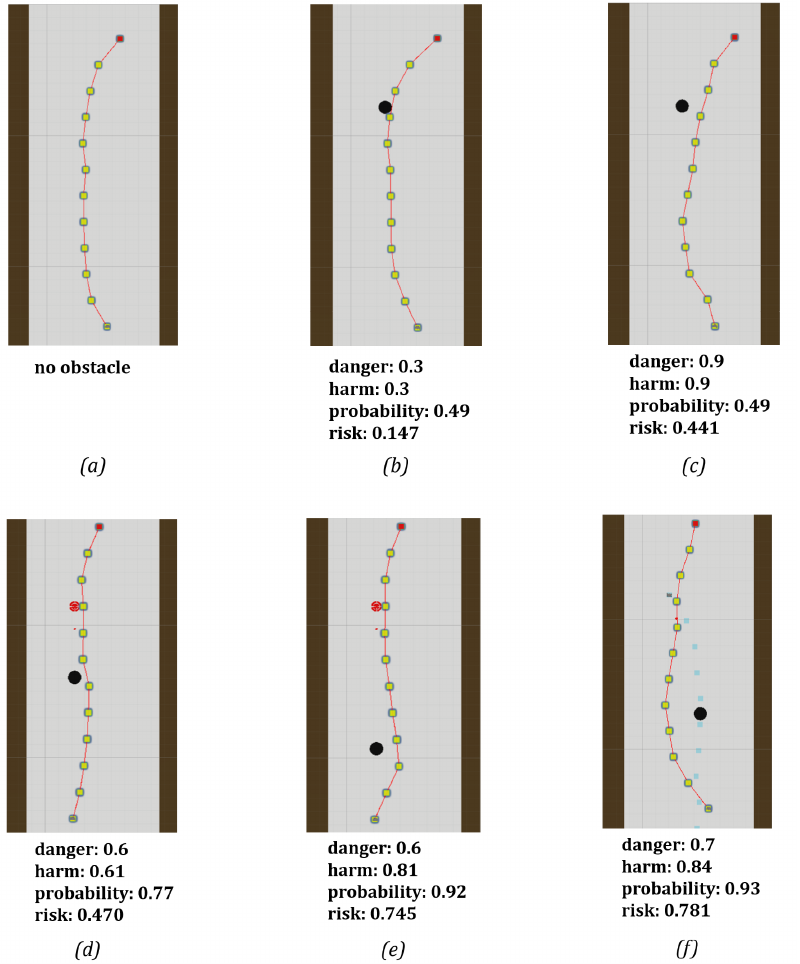
Figure 9. Agent’s planned path in different situations: ( a ) no obstacle; ( b ) with a static obstacle with a low danger level; ( c ) with a static obstacle with a high danger level; ( d ) with an obstacle moving straight in one direction away from the agent ( e ) with an obstacle moving straight in one direction toward the agent; ( f ) with a pedestrian